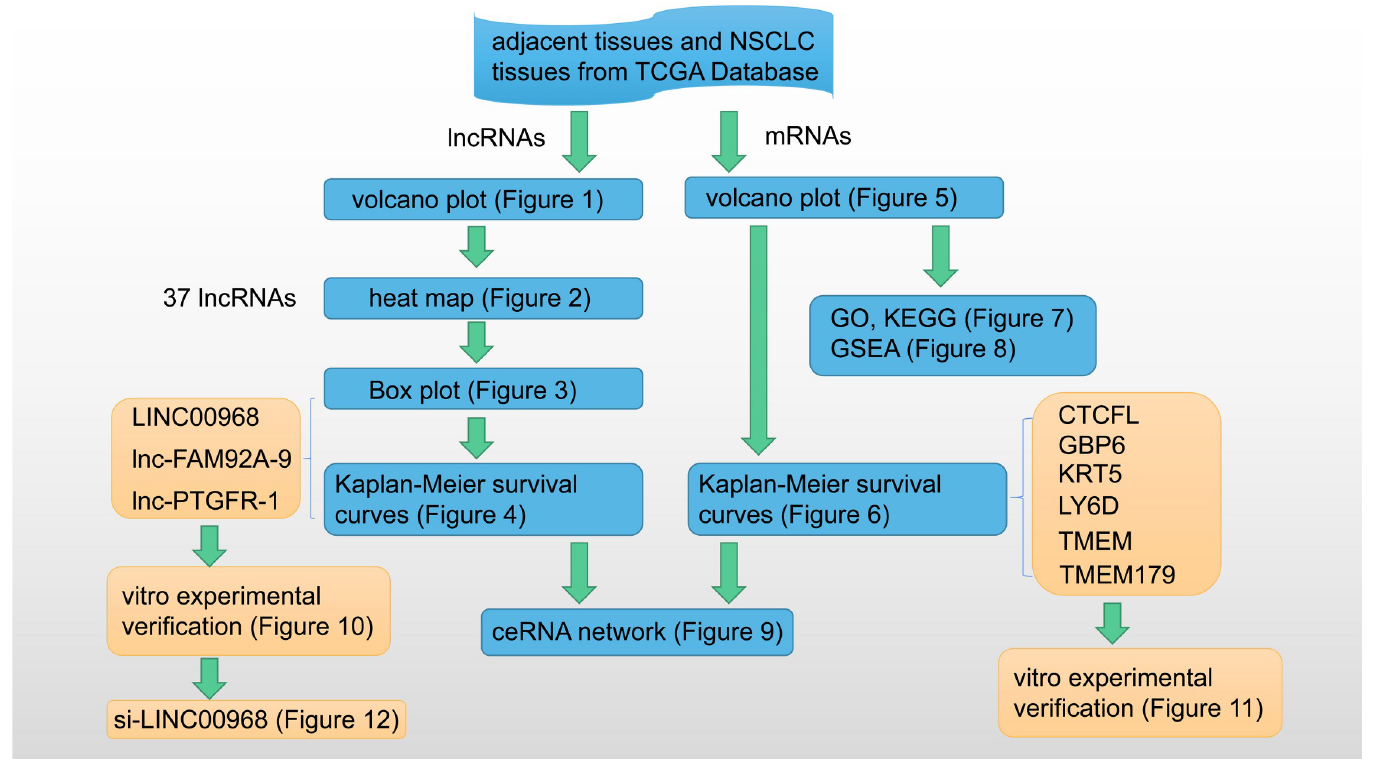
Fig 13. Research process